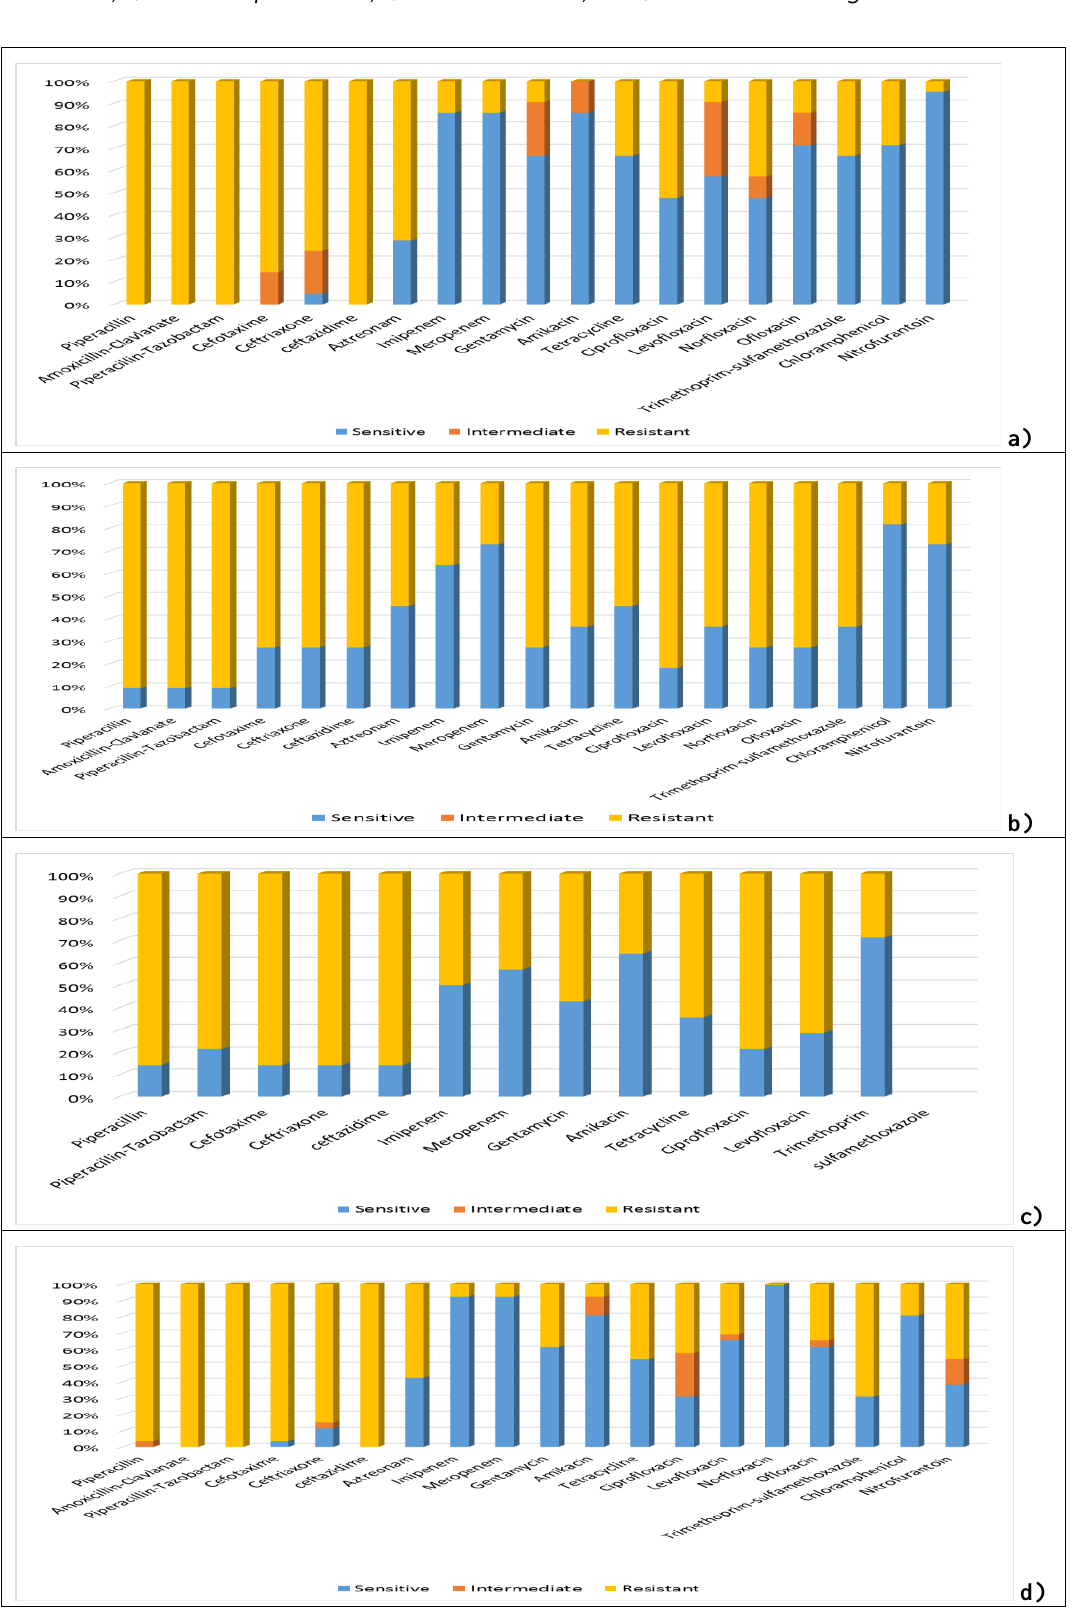
Figure 3. Antimicrobial susceptibility profile of; a) Escherichia coli , b) Enterobacter aerogenes , c) Acinetobacter baumannii , d) Klebsiella pneumonia , e) Proteus mirabilis , and f) Pseudomonas